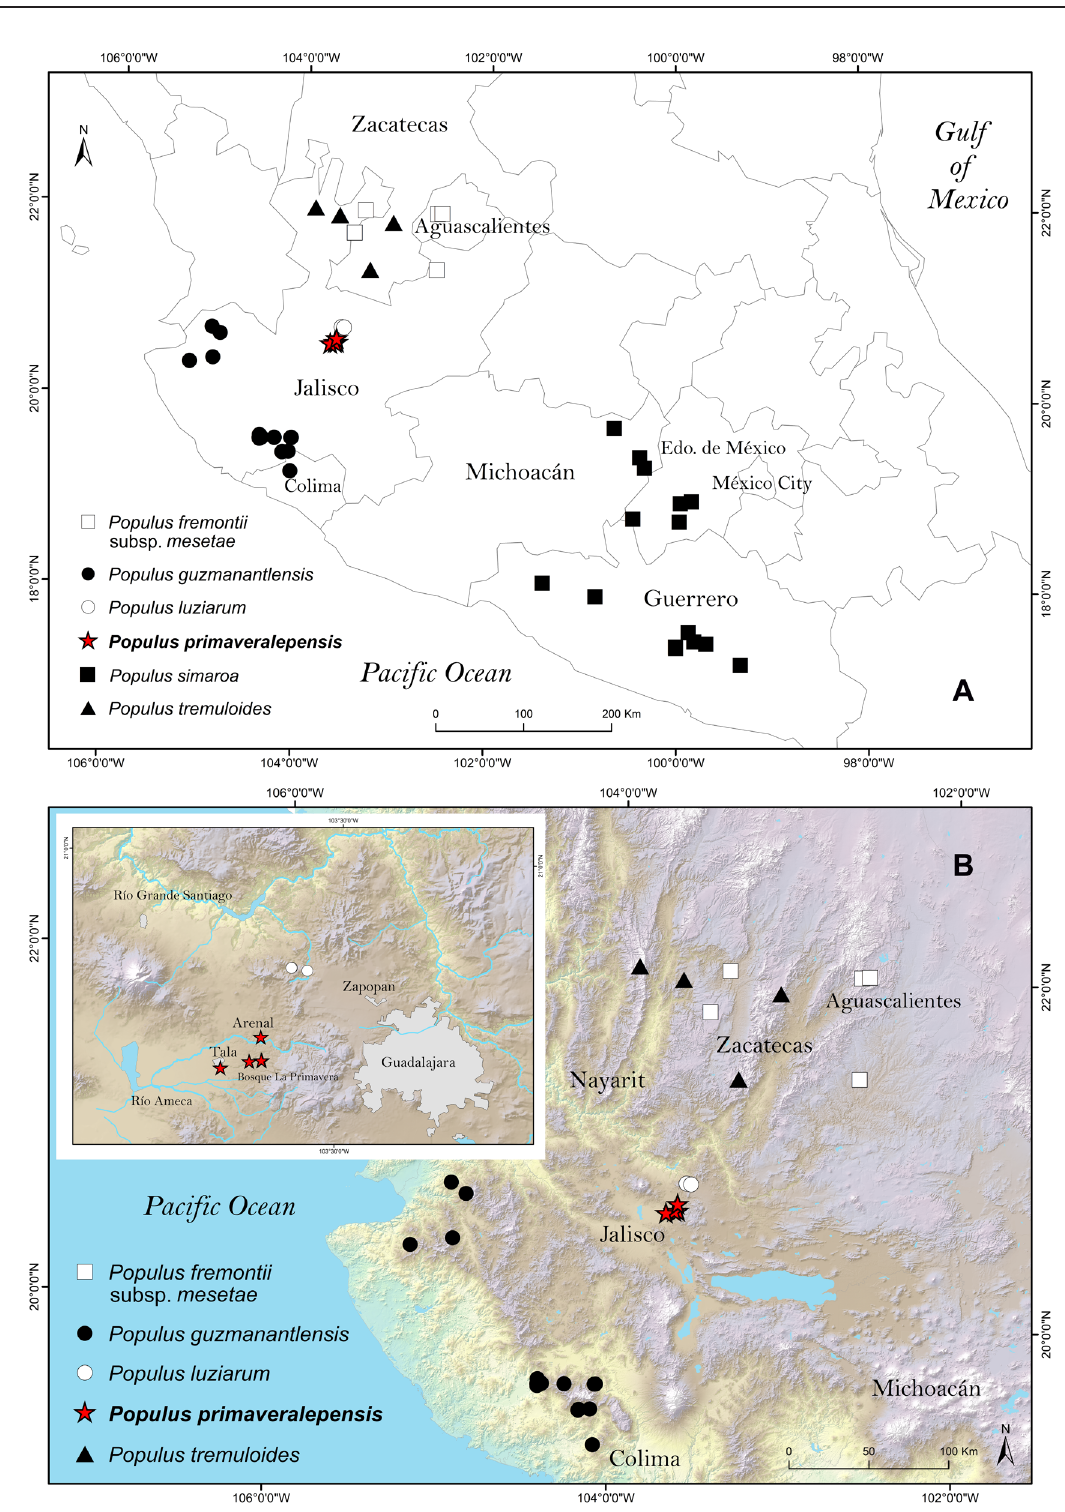
Fig. 5. Maps. A . Distribution of P. primaveralepensis A.Vázquez, Muñiz-Castro & Zuno sp. nov. and related species of Populus L. in western Mexico. B . Distribution of the species of Populus in Jalisco with a close up for P. luziarum A.Vázquez, Muñiz-Castro & Padilla-Lepe and P. primaveralepensis sp.